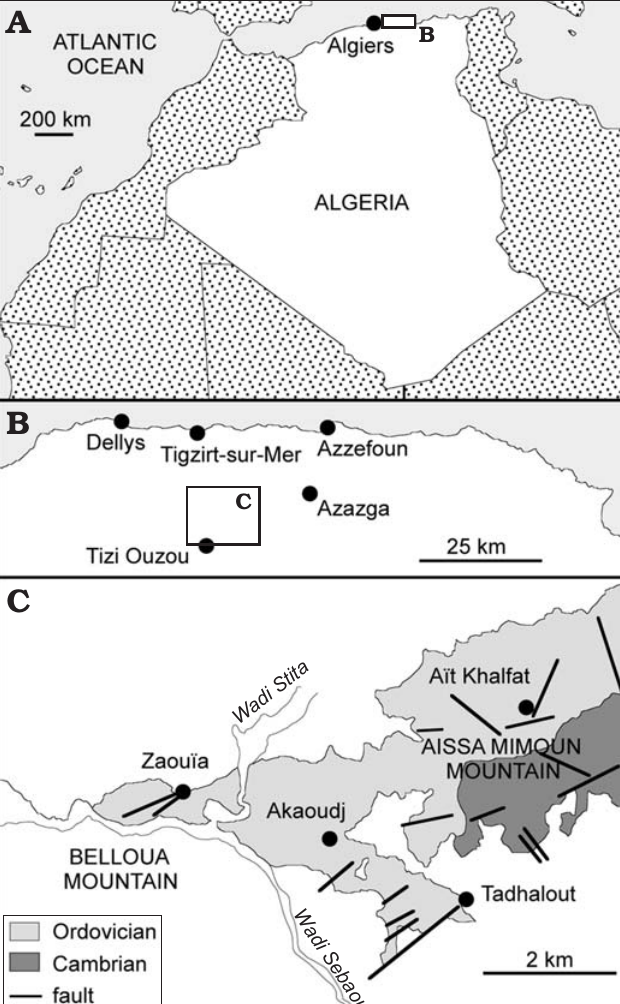
Fig. 2. General map of Algeria ( A ) and northern Algeria ( B ) showing location of the fossiliferous sites (solid circles). C . Geological map of Aissa Mimoun Mountain (Great Kabylia) and location of the studied section (Zaouïa of